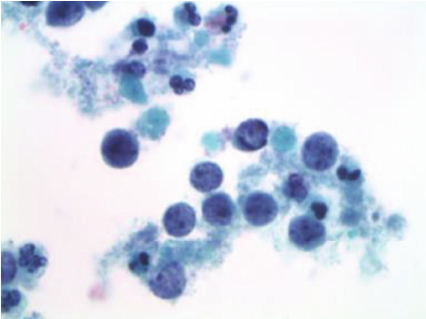
Figure 2: The individual malignant cells are small in size (not larger than twice the size of internal control segmented neutrophils). Areas of granular proteinaceous diathesis material are evident clinging to the lesional cells. Single necrotic cells (apoptotic bodies) are also observed (Papanicolaou stain, ThinPrep, 1000x).